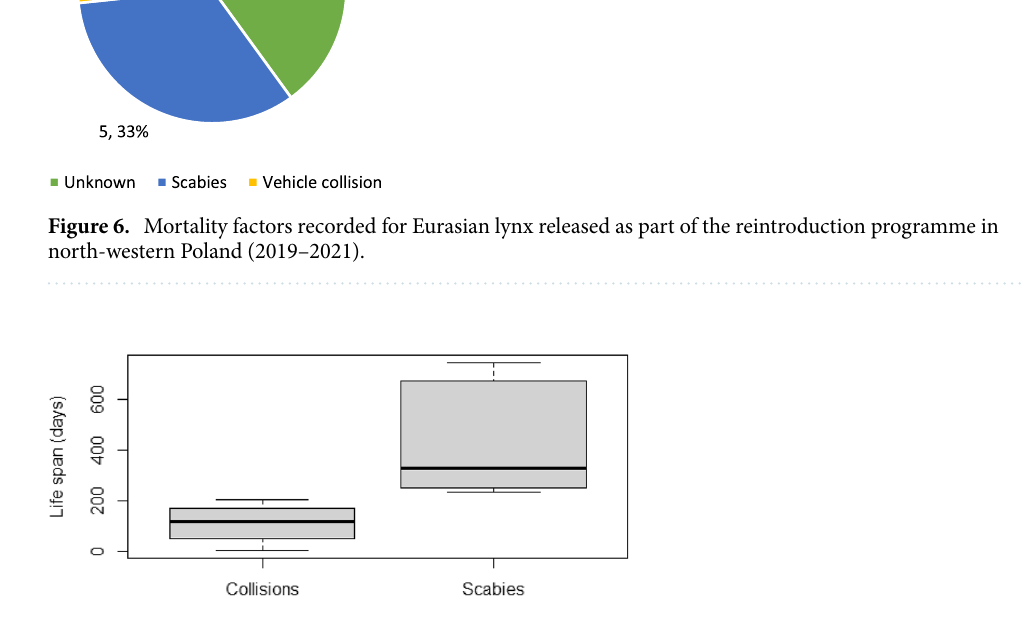
Figure 7. Cause of death of Eurasian lynx, released as part of the reintroduction programme in north-western Poland (N = 9), as a function of the time spent in the wild (the thick line inside each box indicates the median value, the edges of the box are the 25th and 75th percentiles, and the whiskers extend to the most extreme